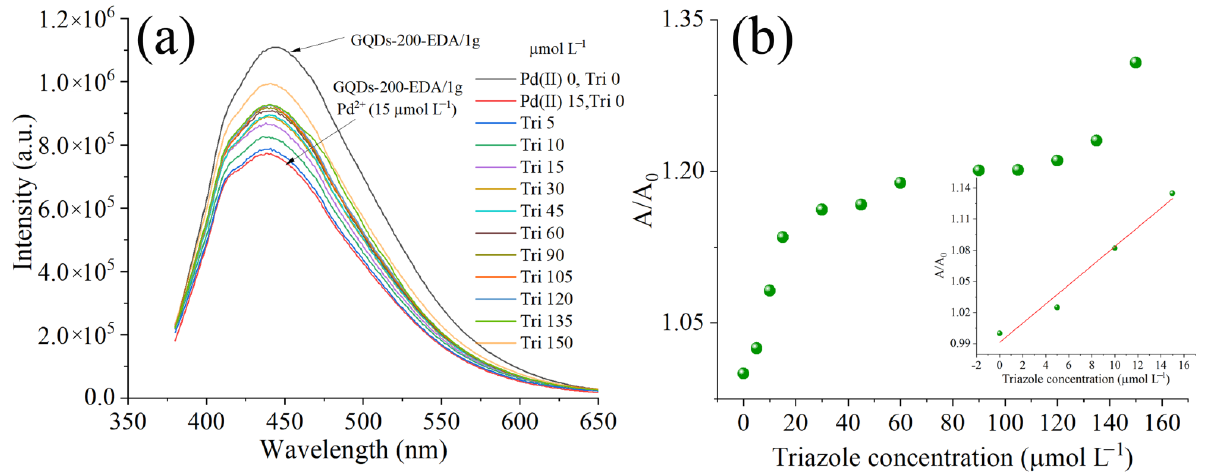
Figure 12. Emission spectra of the GQDs-EDA/1 g, and GQDs-EDA/1 g-Pd 2+ system recorded at λ exc = 360 nm in the presence of 3-amino-1,2,4-triazole in the concentration range 0 – 150 µmol L −1 ( a ), and plot which presents an integrated area under emission peak versus concentration of 3-amino-1,2,4-triazole ( b ), with a linear fitting curve.